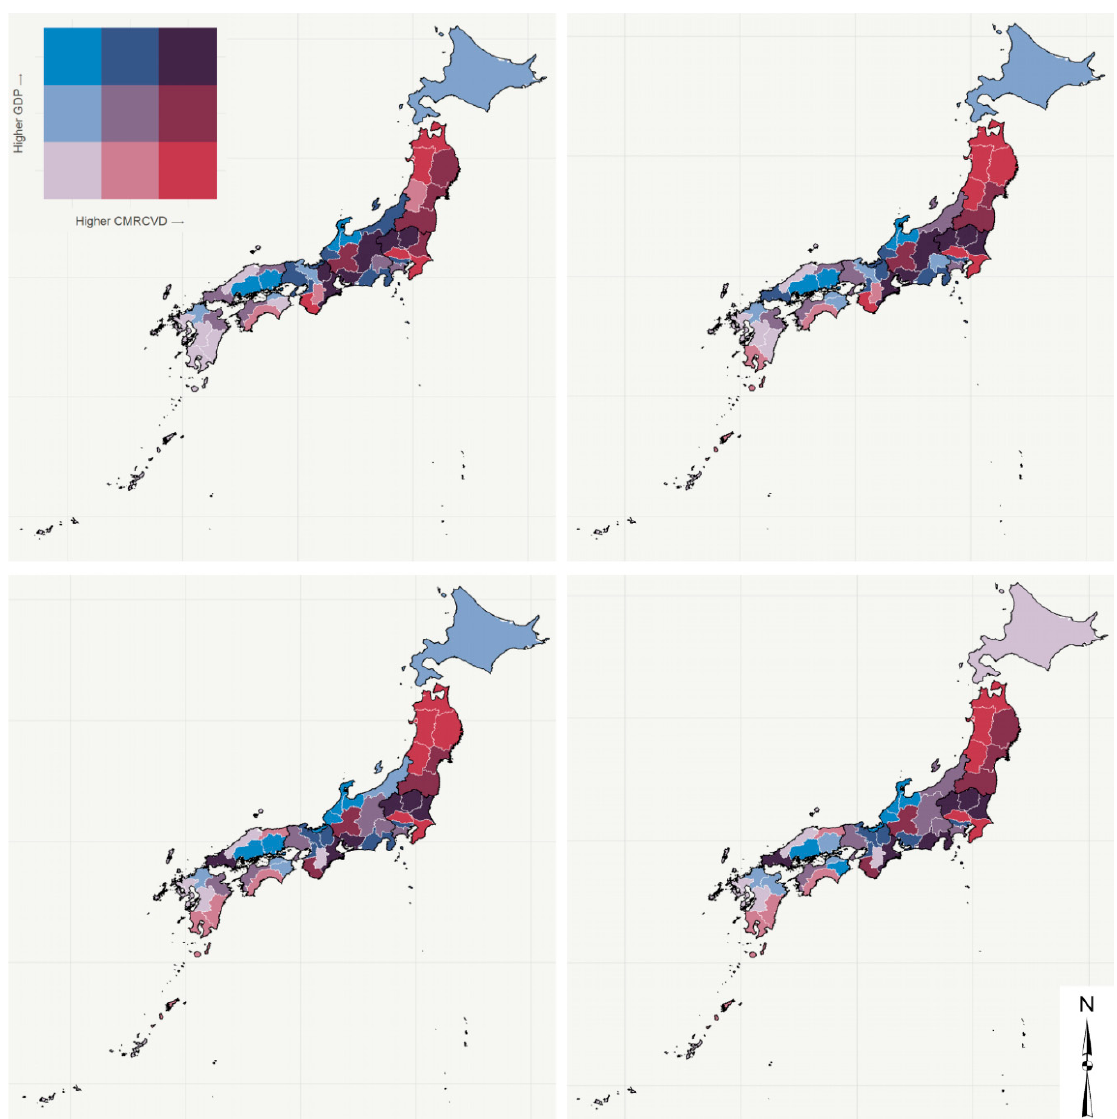
Figure 3. CVD mortality rates vs. GDP per capita, females, prefectures, Japan—time series 1996–2000 ( top left ), 2001–2005 ( top right ), 2006–2010 ( bottom left ), and 2011–2015 ( bottom right ).